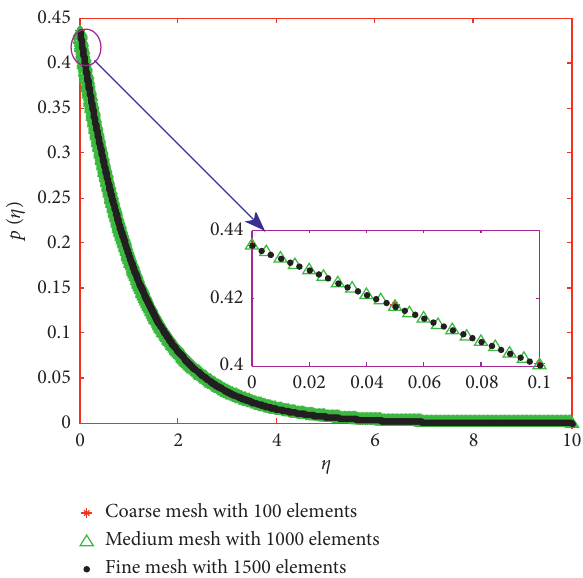
Figure 27: Grid-independence test showing every fifth element of the mesh for angular velocity